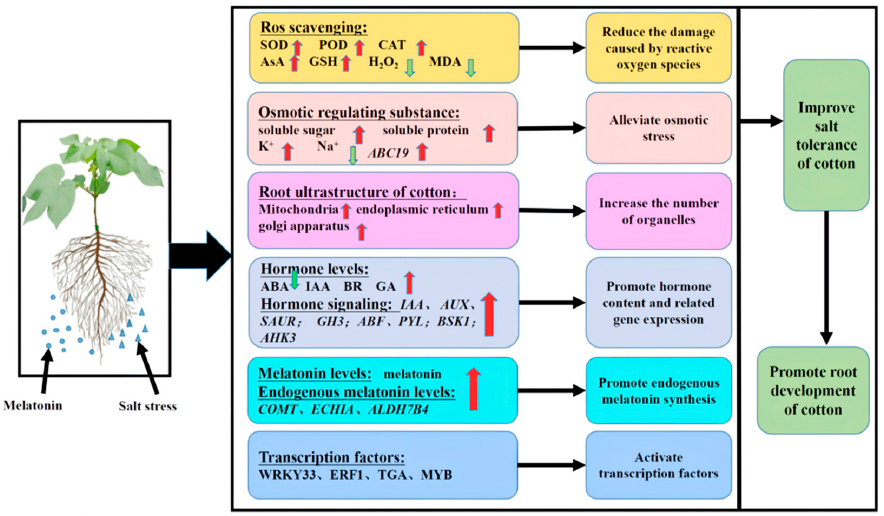
Figure 11. Exogenous melatonin regulates the physiological and molecular patterns of cotton seedling roots and seedlings. Note: SOD, superoxide dismutase; POD, peroxidase; CAT, catalase; GSH, the contents of reduced glutathione; AsA, ascorbic acid; MDA, malondialdehyde; IAA, auxin; ABA, abscisic acid; GA, gibberellin; BR, brassinosteroid; Aux/IAA , auxin protein gene; SAUR , auxin small RNA gene; GH3 , auxin response gene; AHK , cytokinin receptor genes; GID1 , GA receptor gene; ABF , ABA response element binding factor gene; BZR , Br-associated receptor kinase gene; PYL , abscisic acid receptor gene. Red and green arrows indicate increases and decreases, respectively.